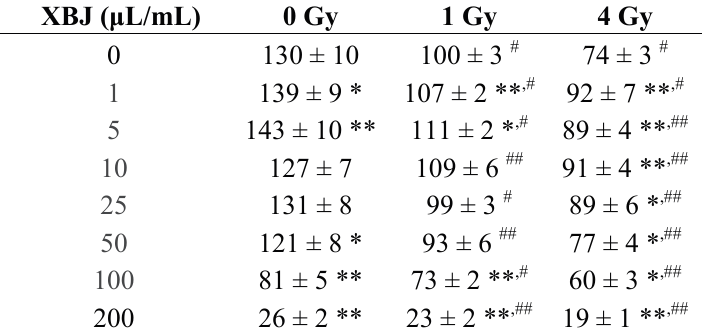
Table 1. The viability (relative light unit × 10 3 ) of bone marrow mononucleated cells (BMMNCs) 6 h after exposure to radiation.